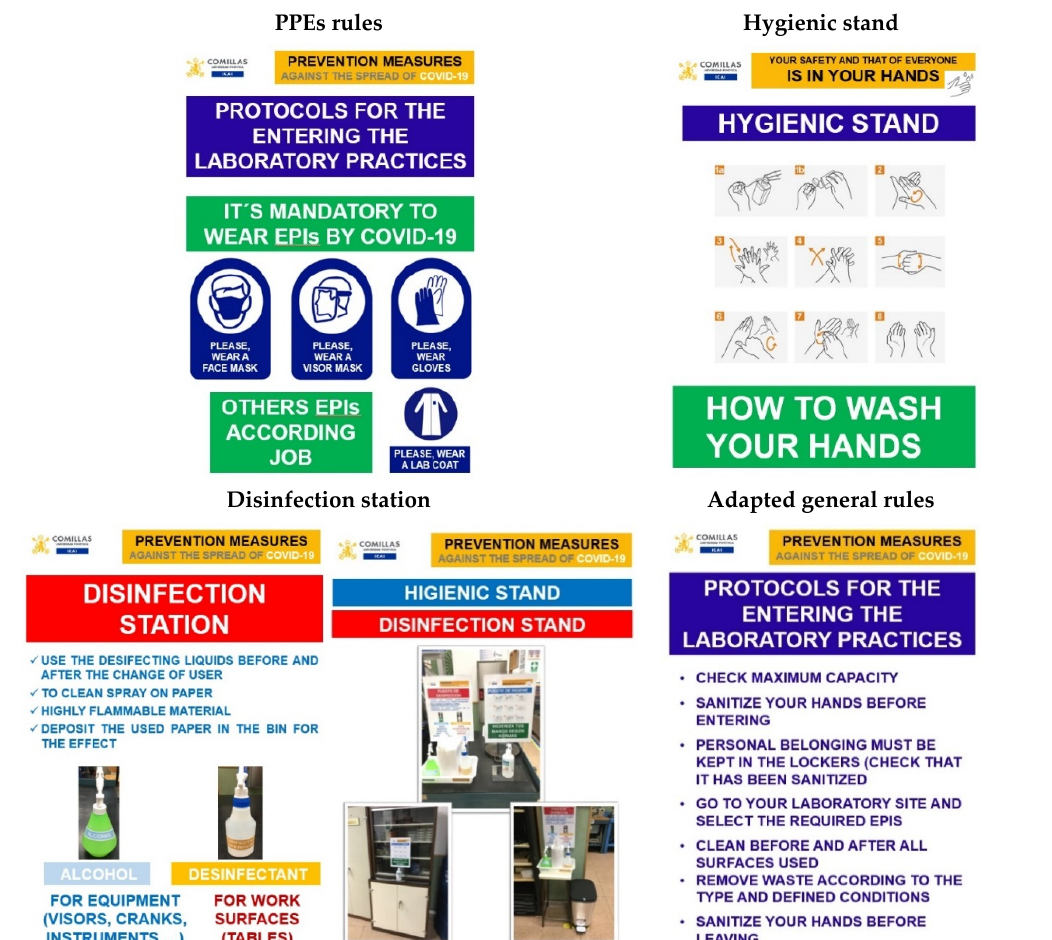
Figure 7. Adapted posters for carrying out the laboratory tests.